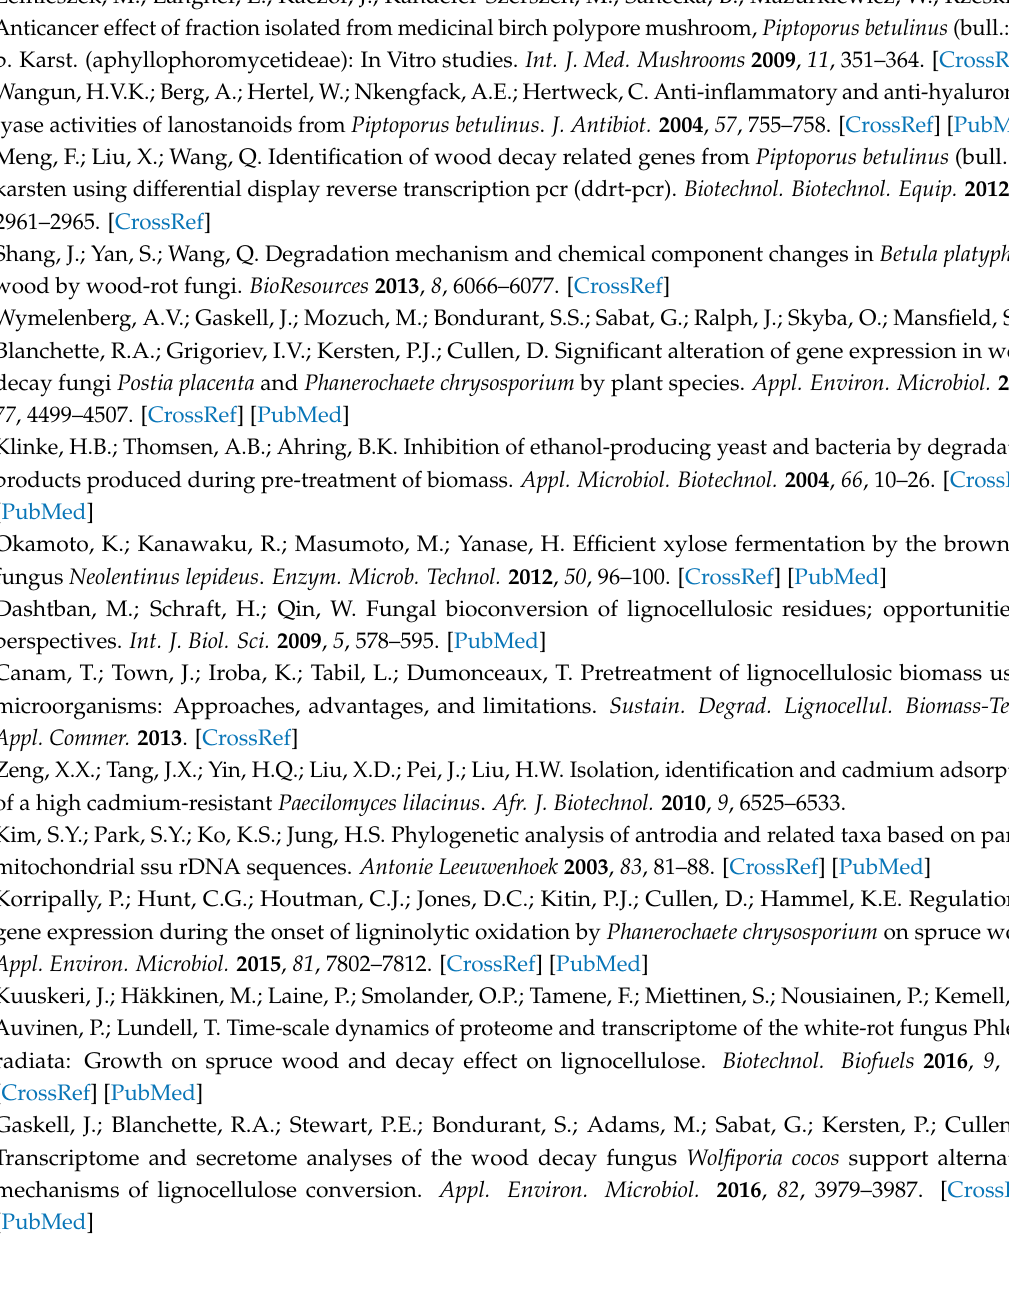
Table S1: The primers designed for qRT-PCR analysis, Table S2: Overview of output statistics on P. betulinus transcriptome sequencing, Table S3: The top 20 representative metabolic pathways of P. betulunus , Table S4: The list of significantly differently expressed genes, Table S5: The metabolic pathway of differently expressed genes in samples, Table S6: All the assembled unigenes functionally annotated in Nr